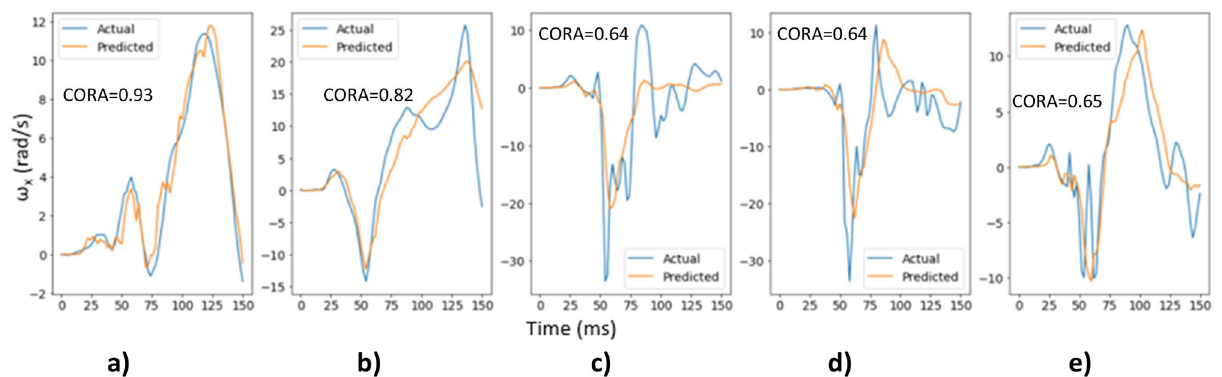
Figure 8. Actual and predicted time histories for ω x for 5 random cases from the test